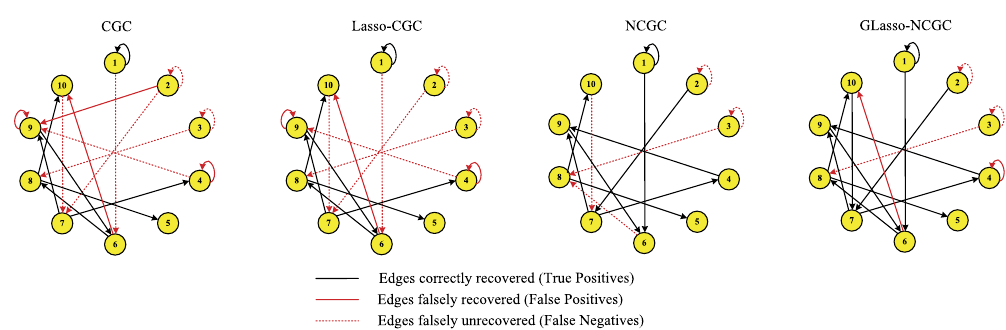
Figure 1. Directed graph and true adjacency matrix of nonlinear VAR model.